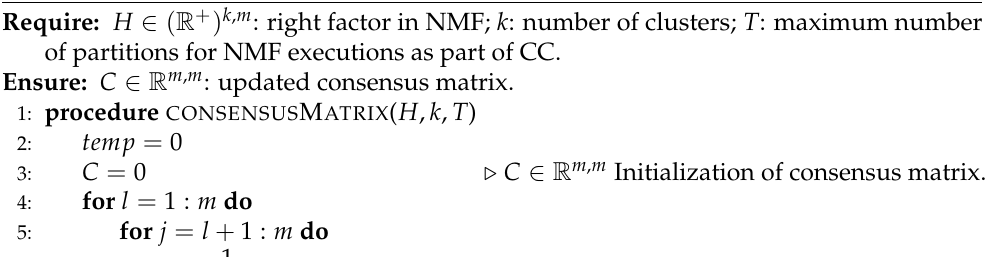
Algorithm 2 Consensus matrix update for the i -th